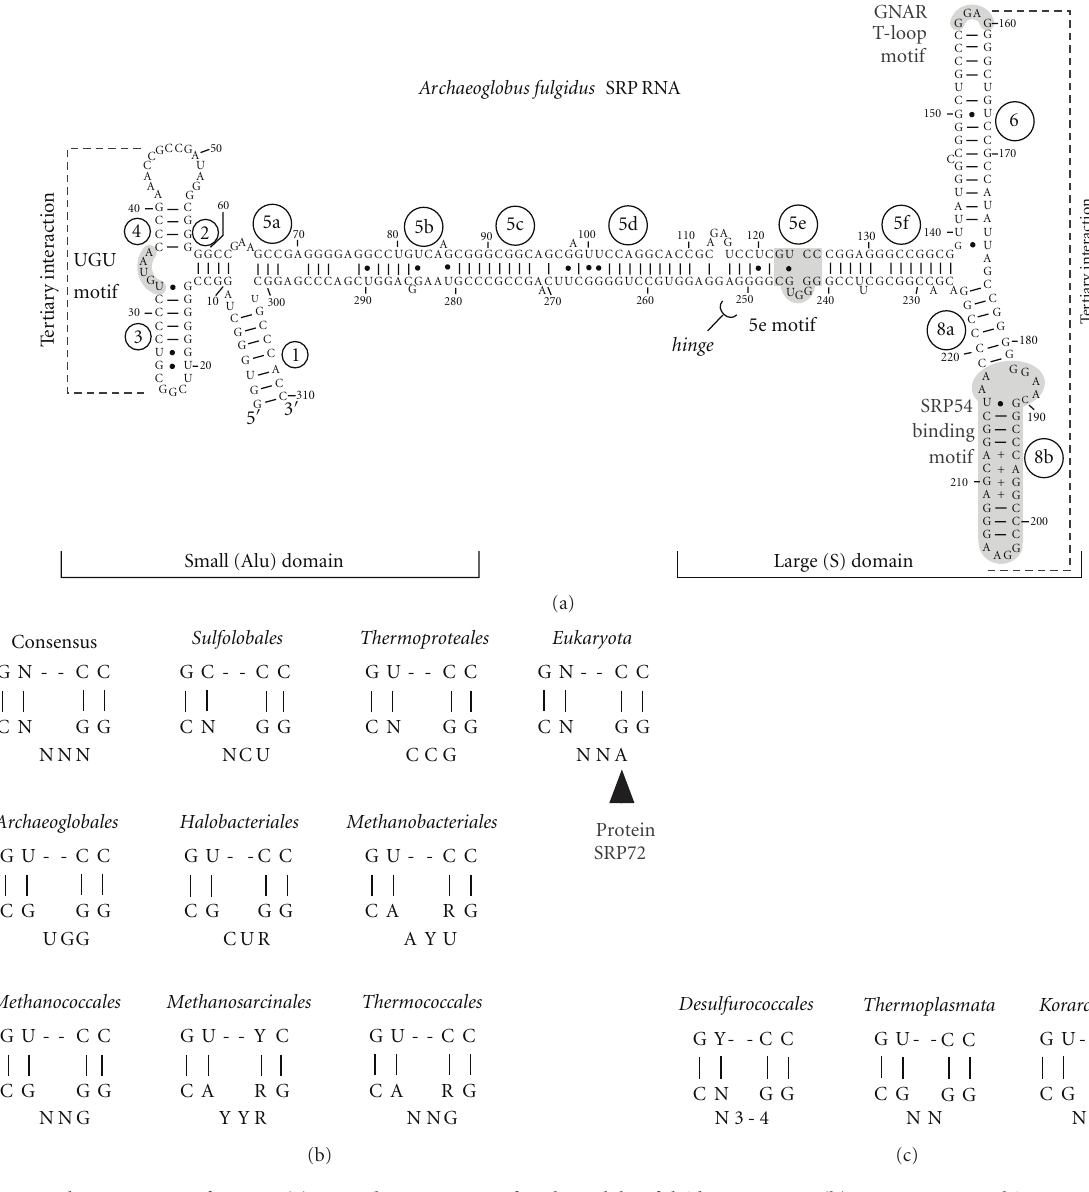
SRP RNAs, but deviates (AAAG) from the consensus in the four SRP RNA sequences of the Thermoplasmatales.